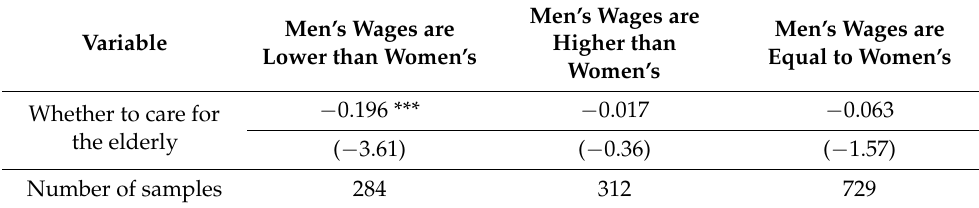
Men’s Wages are Men’s Wages are Higher than Equal to Women’s Women’s